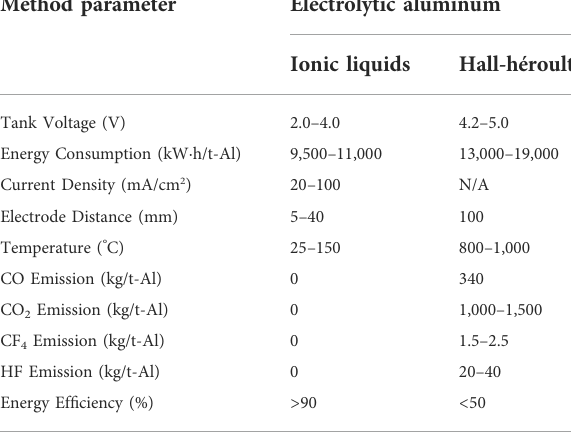
TABLE 3 Comparison of the technical and economic indices between ionic liquids and the Hall – Héroult method. Method